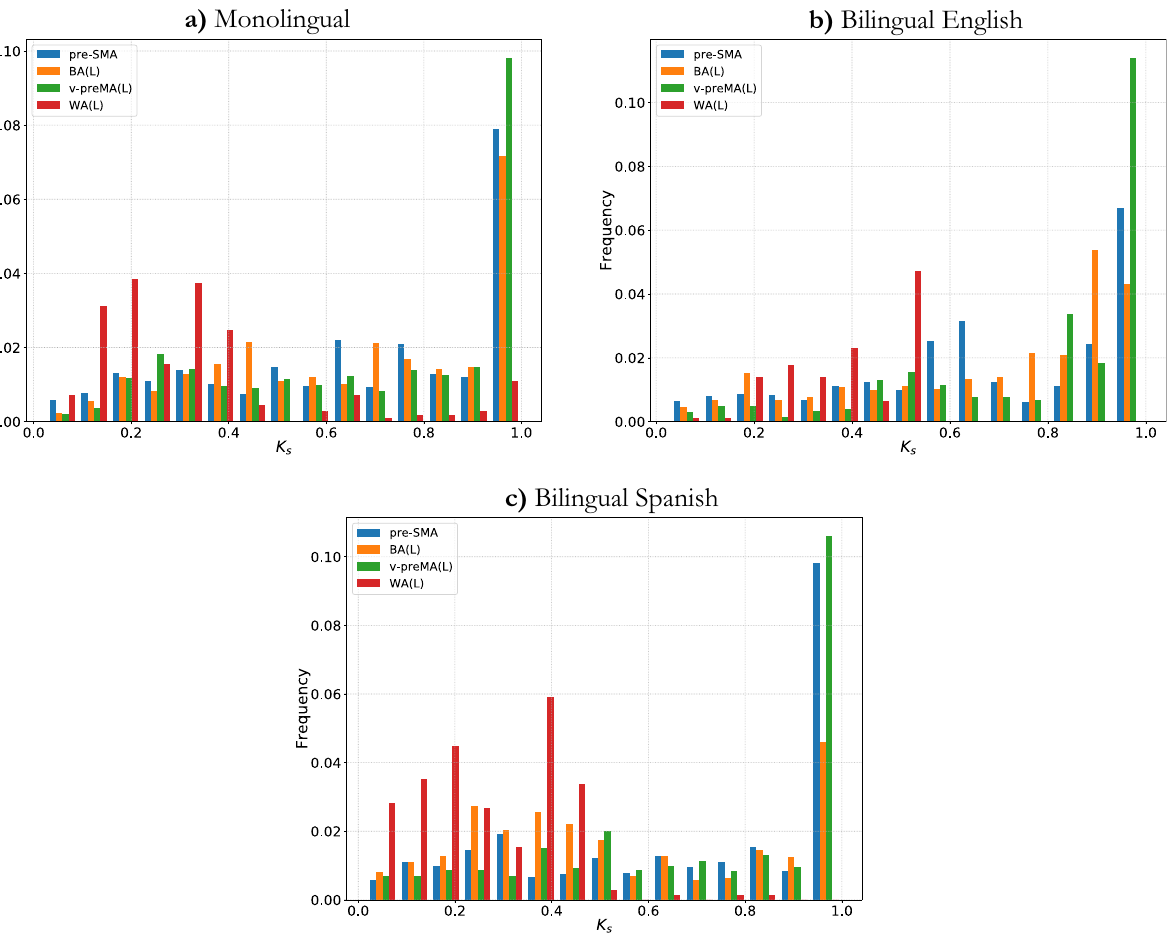
Figure 5. K -shell occupancy for all three groups. Different colors represent nodes belonging to different modules, and the color legend is shown in the upper left of the figure. In ( a )–( c ) pre-SMA, BA(L), and v-preMA(L) peak at the maximum shell; however, WA(L) occupies most of the middle and low shell. In ( b ), WA(L) does not occupy the higher ( k s > 0.5) shell at